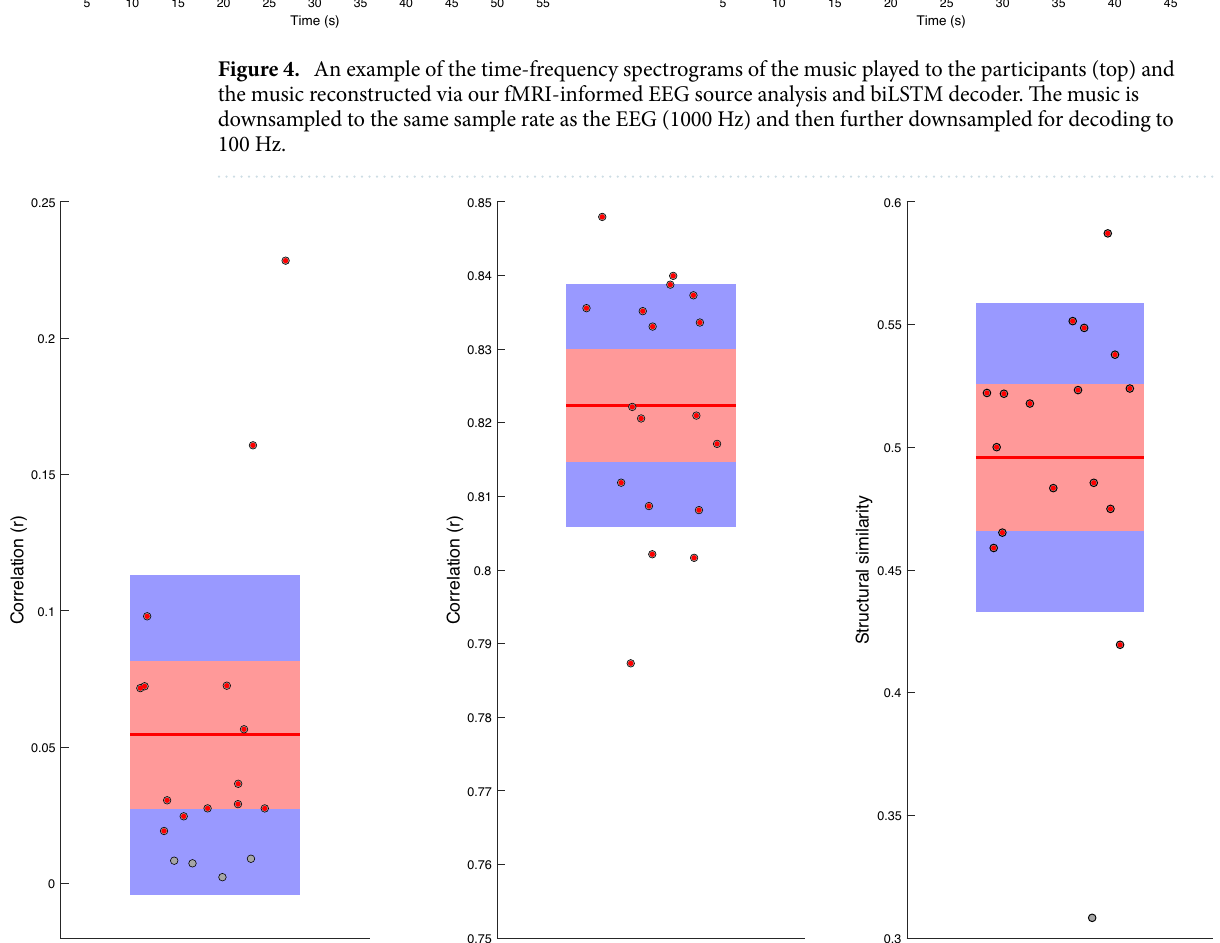
Figure 5. Relationships between music played to the participants and music reconstructed via our fMRI- informed EEG source analysis approach. Correlation coefficients are shown in the time domain (left) and frequency domain (centre). The right figure shows structural similarity measures between the time- frequency spectra of the original and reconstructed music. Significant measures ( p < 0.05 ) are highlighted in